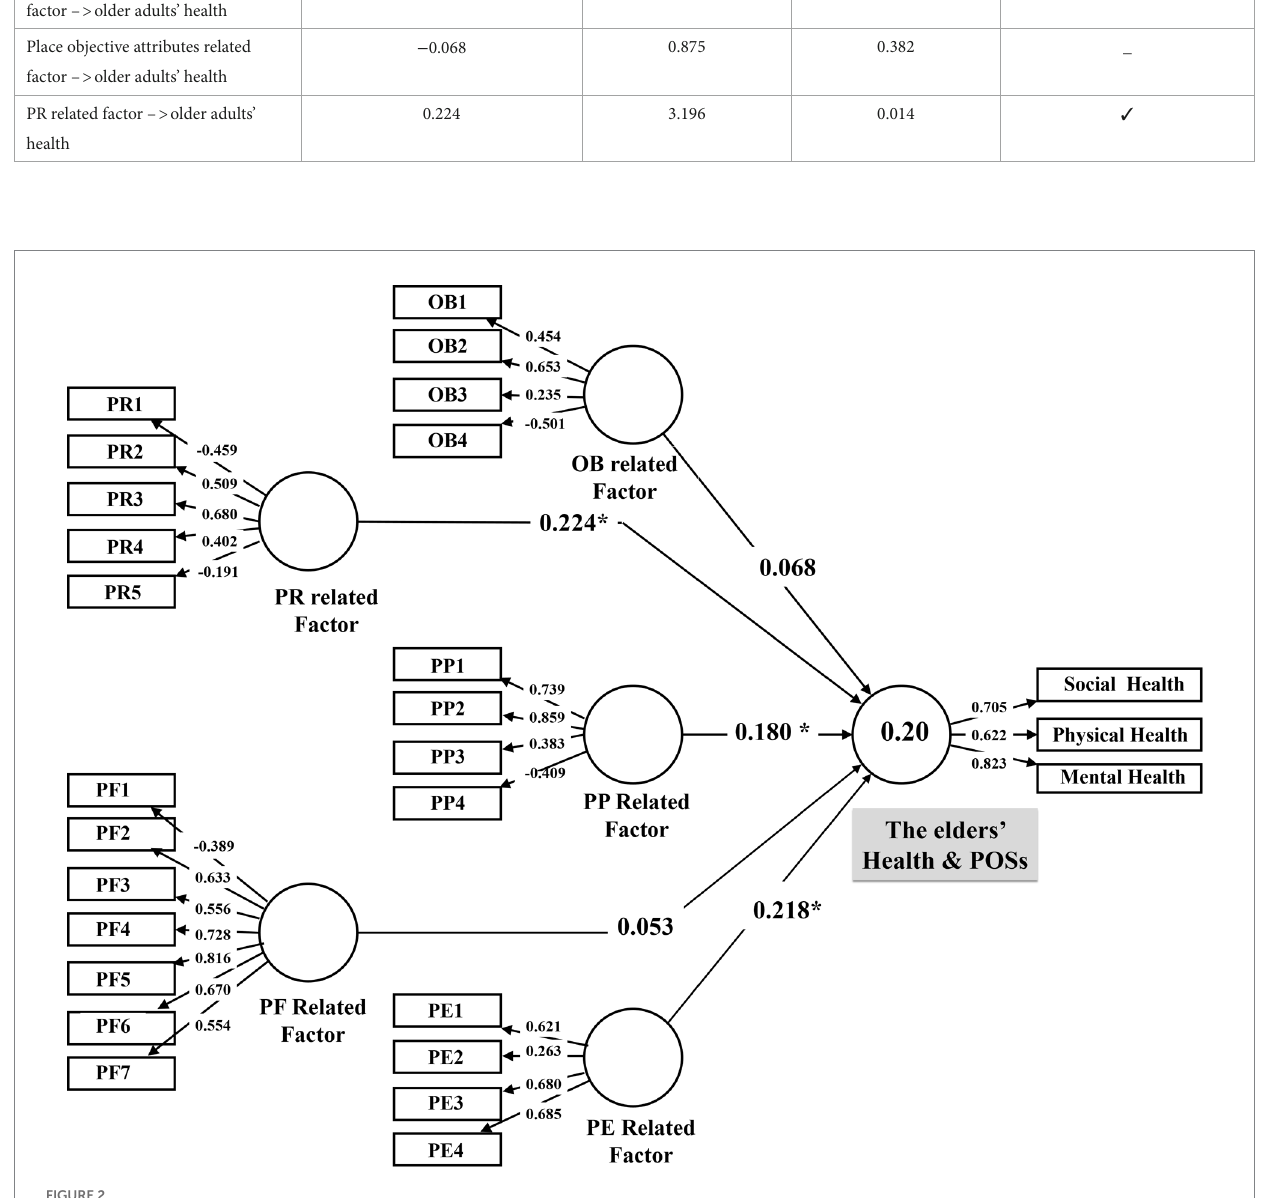
FIGURE 2 The path model. (Coefficient * p <